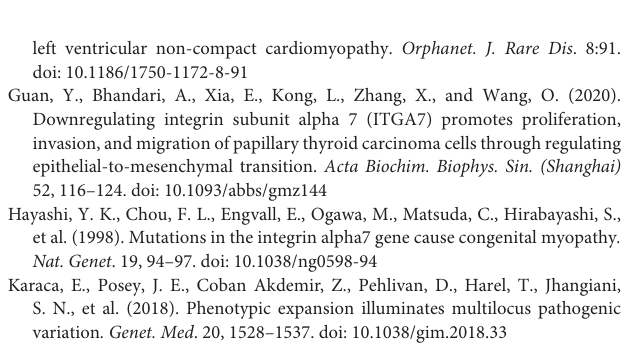
Supplementary Table 2 | Nerve conduction studies of the brother of the proband. L, left; R, right; Lat, latency; Amp, amplitude; Dis, distance; CV, conduction